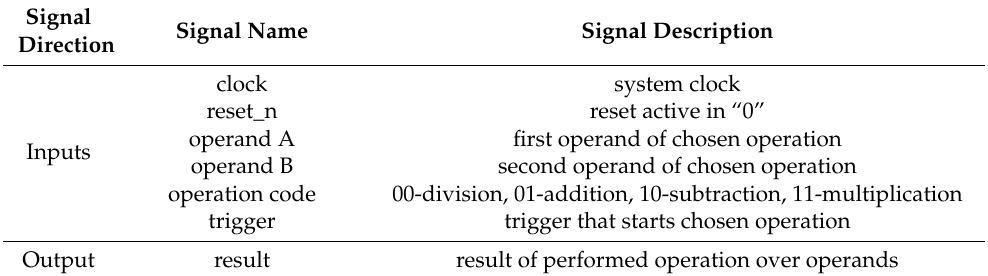
Table 2. External module signals and their